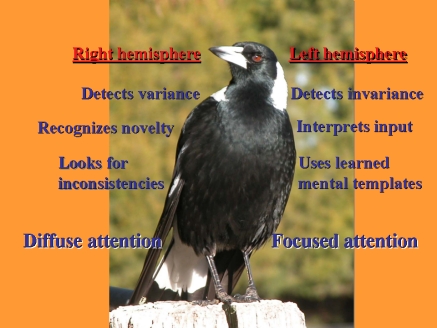
Lateralization in the Avian Brain, Illustrated Using the Australian Magpie, Gymnorhina tibicen
Behaviour controlled by the left and right hemispheres is listed. As in humans, functions of the left hemisphere are consistent with those of autistic humans. (Photograph: G. Kaplan, Centre for Neuroscience and Animal Behaviour, University of New England, Australia)